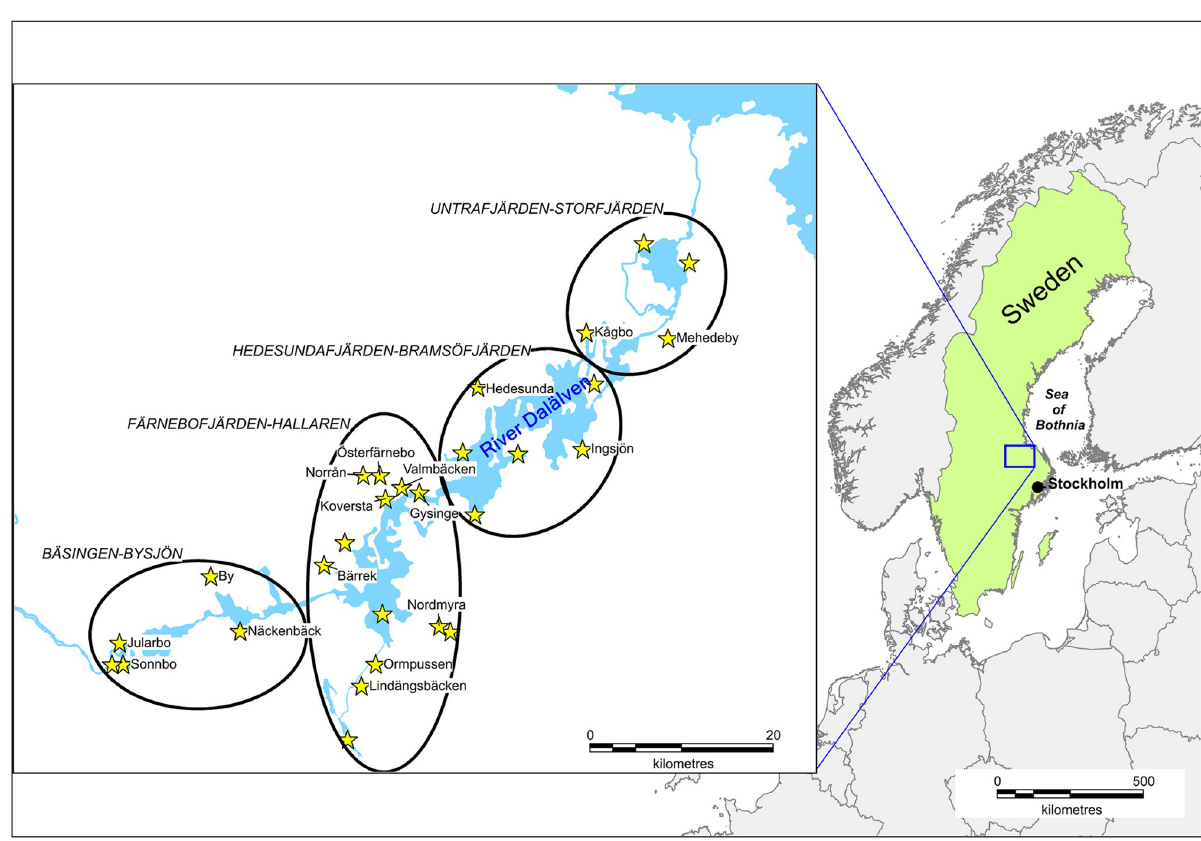
Fig 3. The study sites in the River Dala¨lven floodplains of central Sweden are located within the endemic area for Ockelbo disease caused by mosquito- borne Sindbis virus. Visualized on the magnified map are the BMC mosquito surveillance (http://www.mygg.se) trap sites with names provided for sites where virus occurred in vector mosquitoes. The ovals show our division of the study sites into four geographic locations named after the major lakes